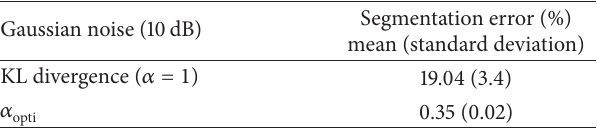
Table 1: Average segmentation error in percentage of misclassified pixels function of the strategy used for the setting of 𝛼 parameter (KL or